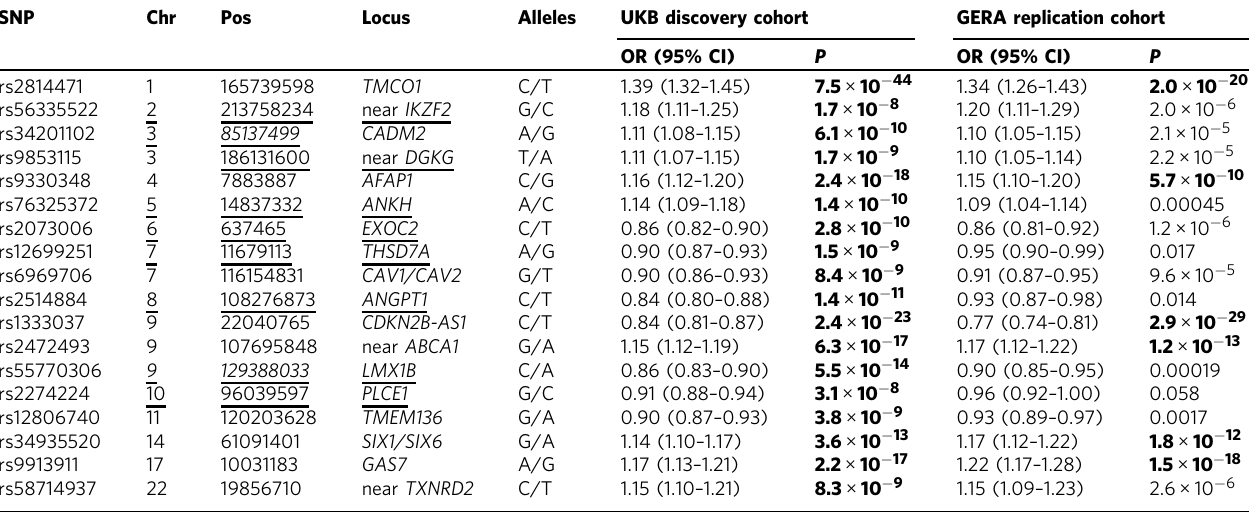
Table 3 Lead genome-wide signi fi cant SNP for each independent locus identi fi ed in the UK Biobank and replication in GERA SNP